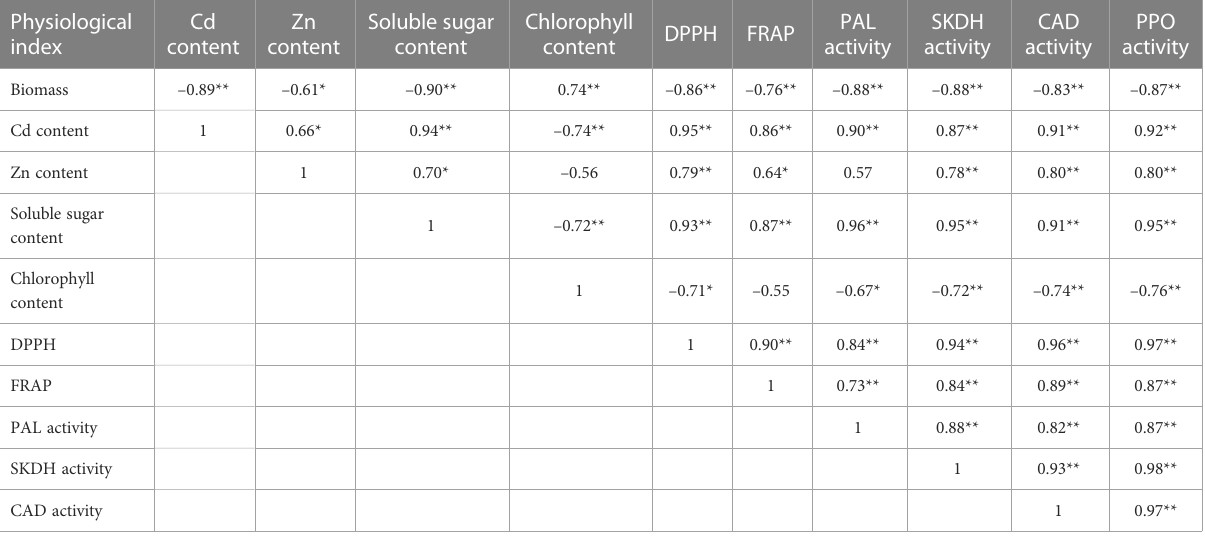
TABLE 5 Pearson correlation coef fi cients among biomass, the contents of Cd, Zn, soluble sugar, chlorophyll and the activities of DPPH, FRAP, PAL, SKDH, CAD and PPO in the leaves of Cd-contaminated Kandelia obovata . Physiological